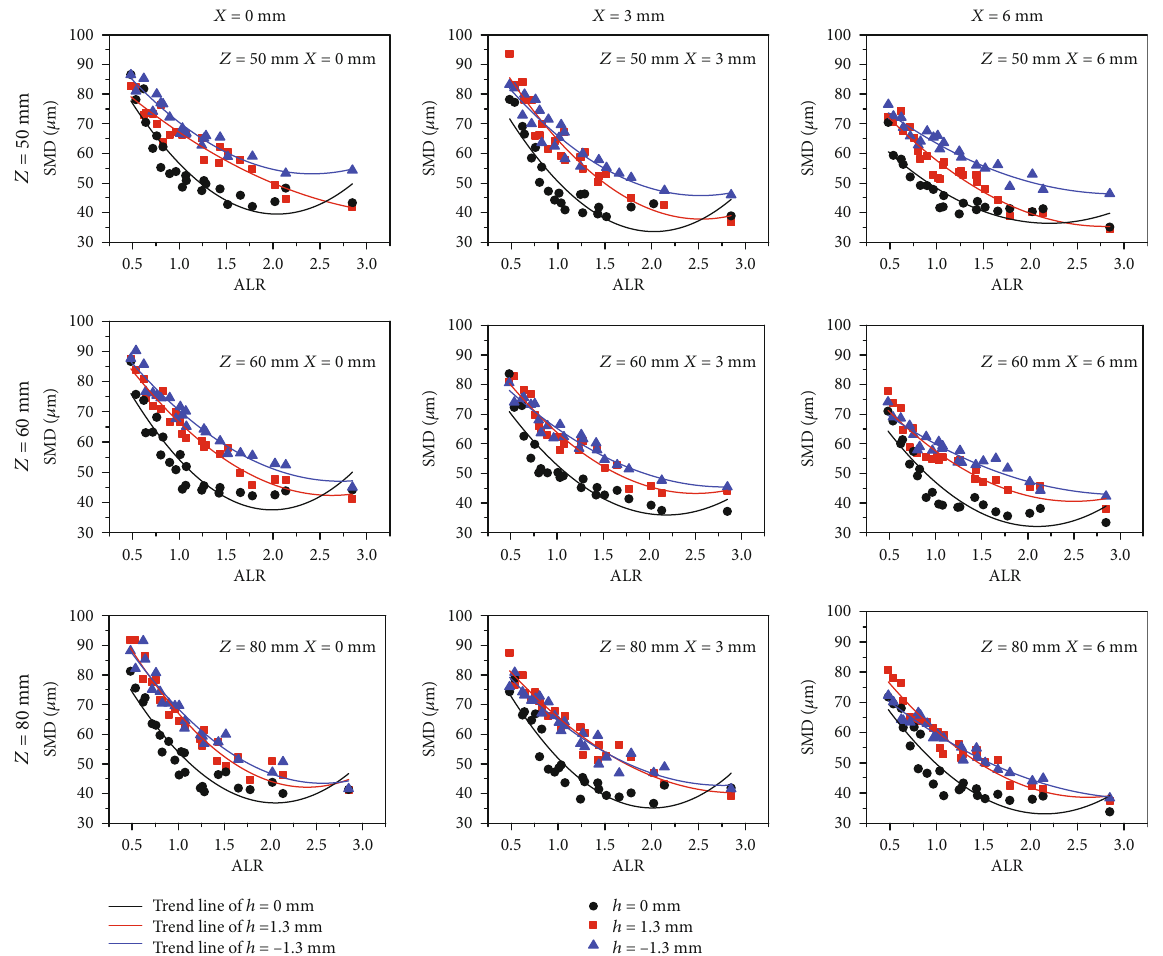
Trend line of h = 0 mm Trend line of h =1.3 mm Trend line of h = –1.3 mm Figure 16: Comparison of SMD characteristics of h series nozzle at various downstream axial distances.